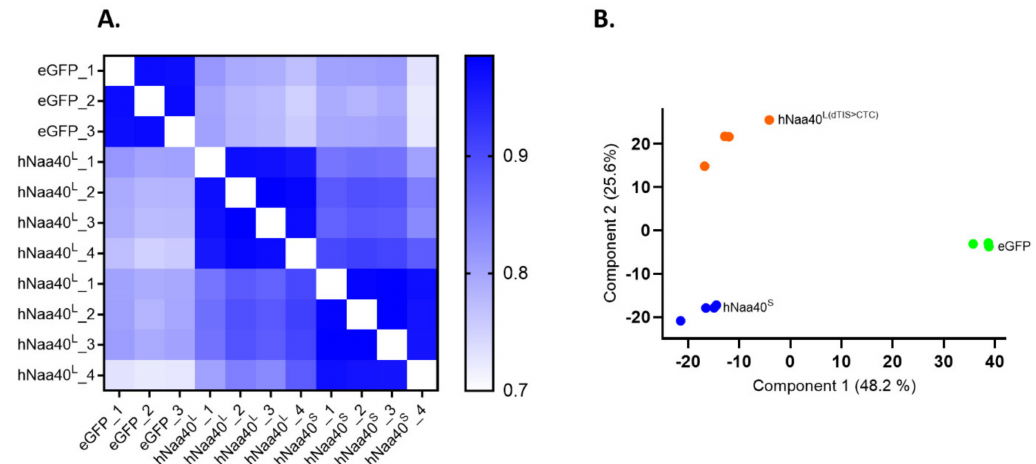
Figure 9. Heat map visualization of pairwise LFQ correlations (Pearson) ( A ) and PCA ( B ) plot of the variability between the different setups and replicate BioID samples analyzed. Green, blue and orange indicate eGFP, hNaa40 L(dTIS>CTC) (in A. shortly referred to as hNaa40 L ) and hNaa40 S setups, respectively.